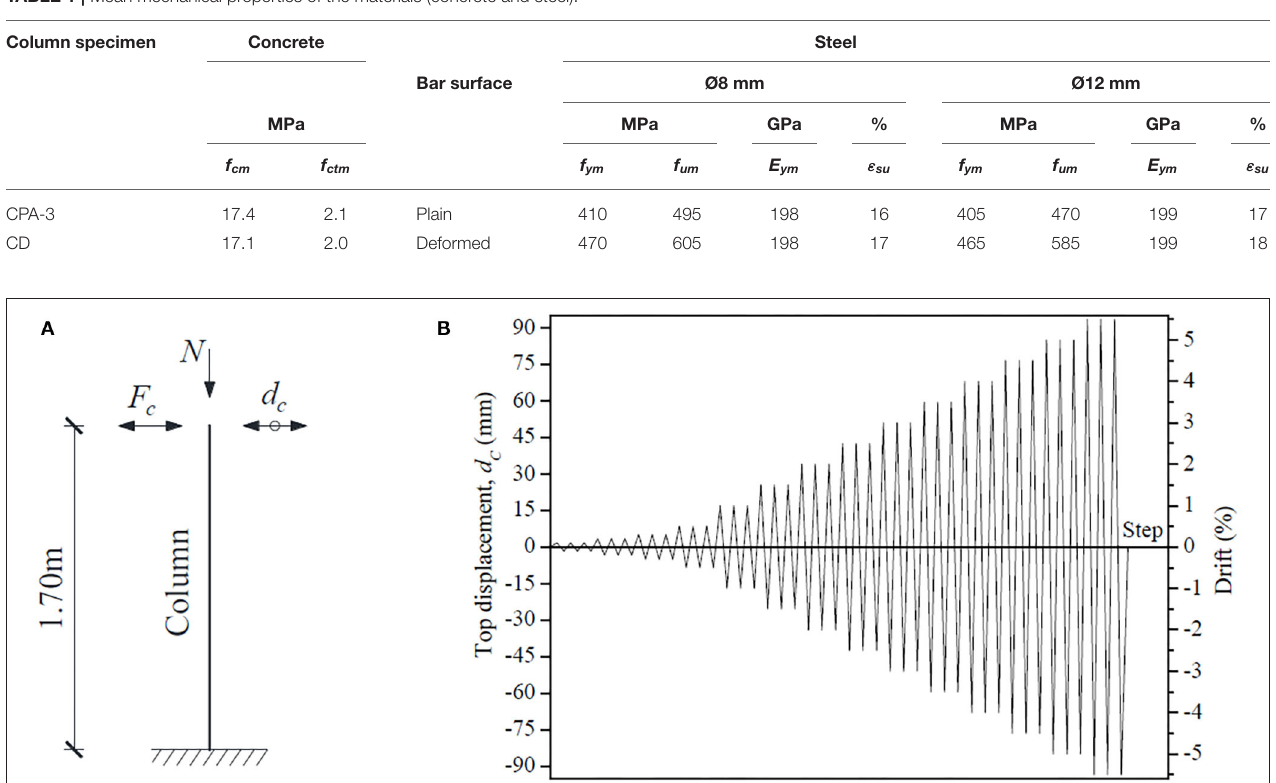
FIGURE 2 | (A) Support and loading conditions idealized; (B) imposed lateral displacement